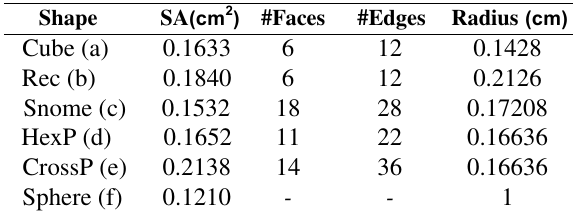
Table 1. Shape properties of 0.1 cm radius volume equivalent polyhedra.